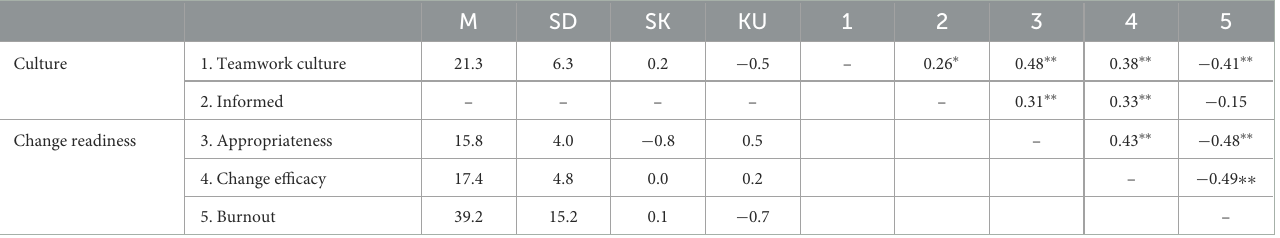
TABLE 2 Descriptive statistics and correlations for study